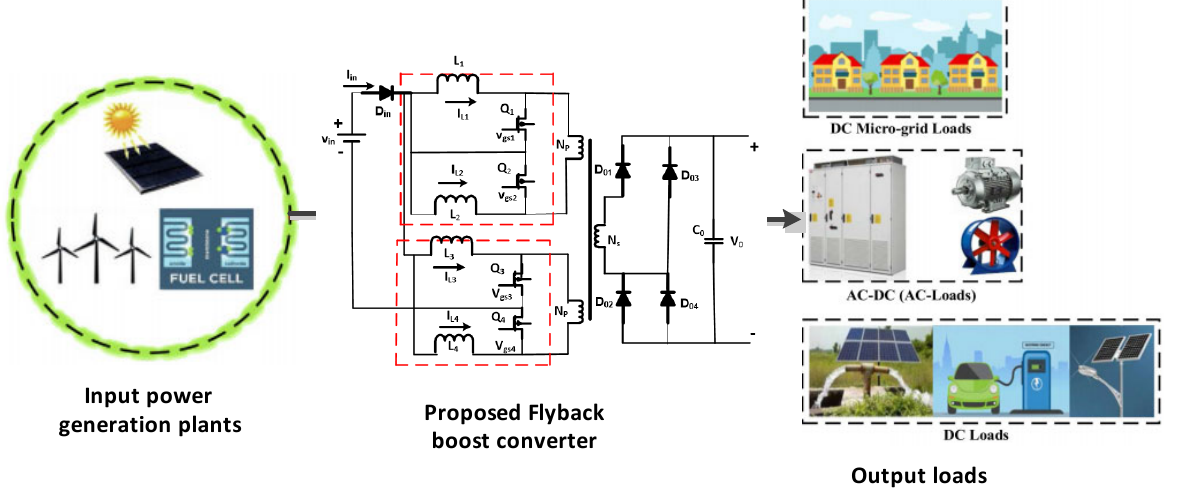
Figure 2. Proposed Flyback ‐ based converter.